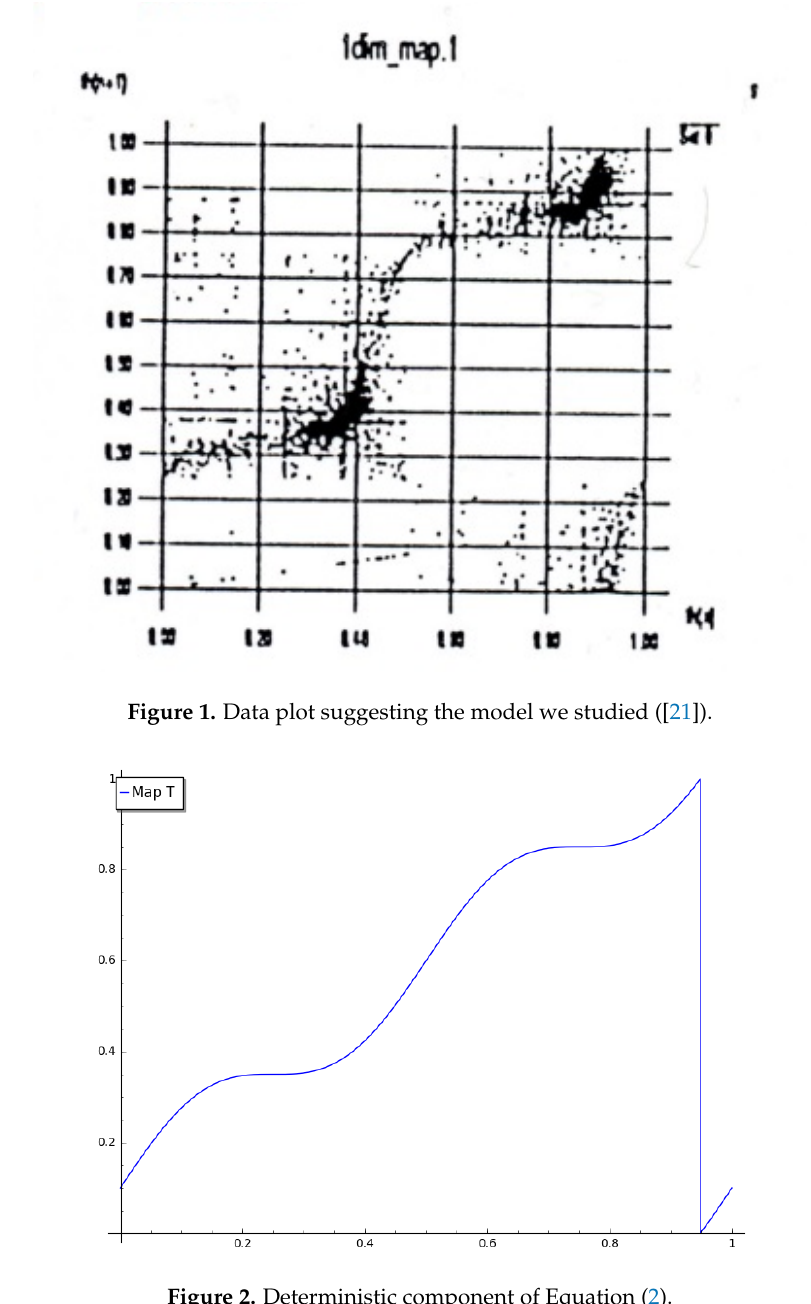
Figure 2. Deterministic component of Equation